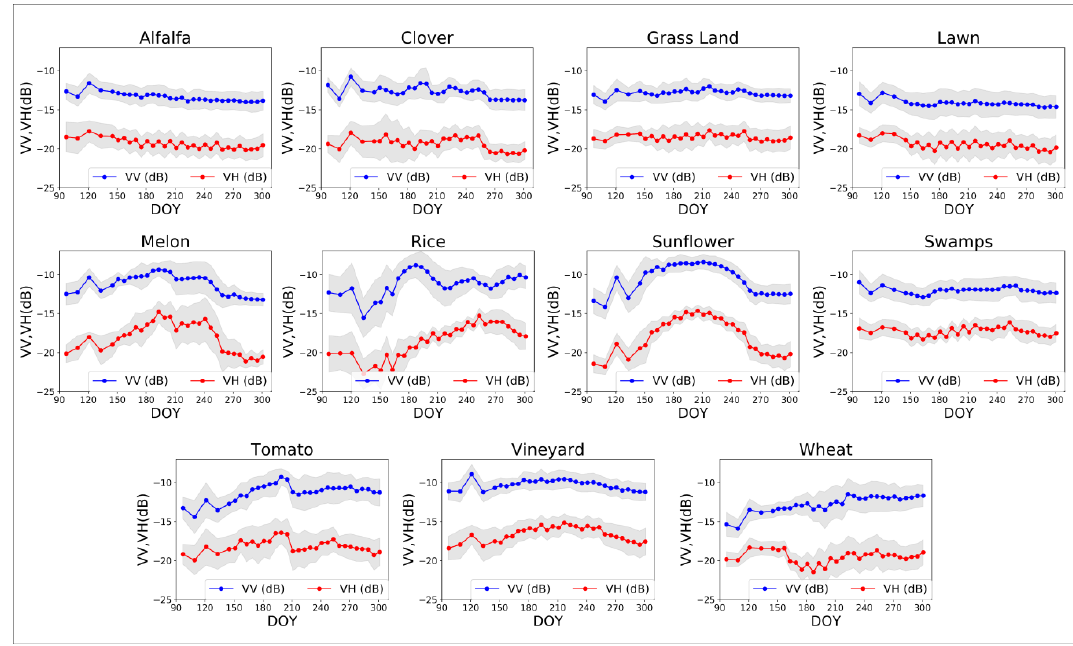
Figure 4: Temporal evolution of SAR backscattering coefficient σ° of 11 crop types for VV and VH polarizations. Mean values are represented by dots and standard deviations are represented by the filled color domains surrounding the curves.